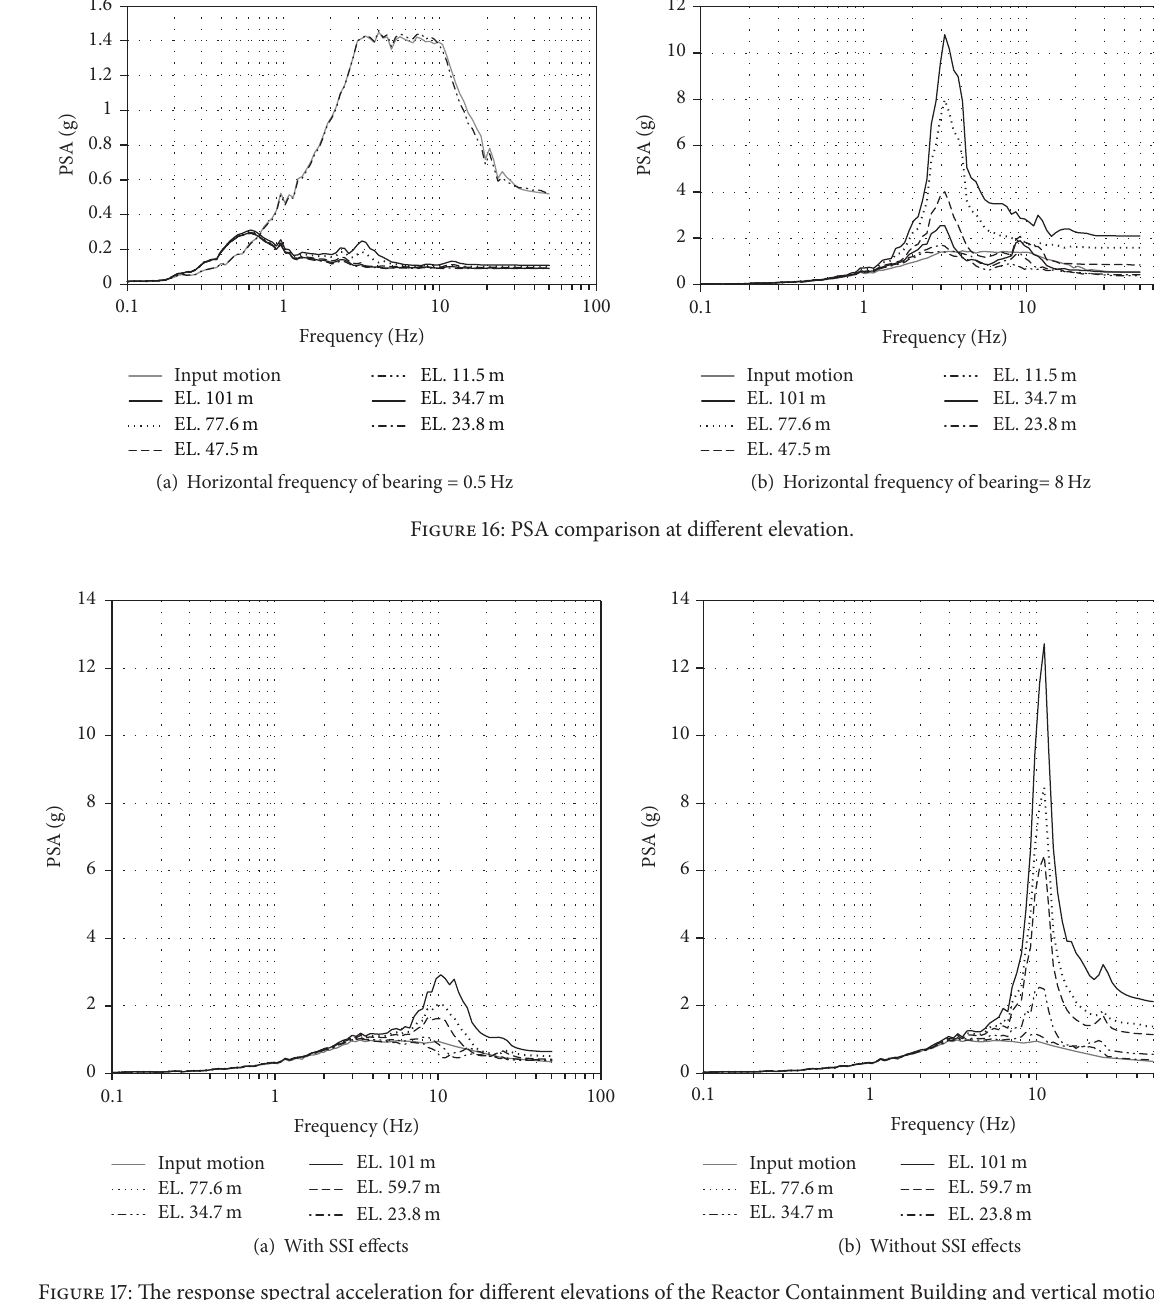
displacement with and without SSI effects is